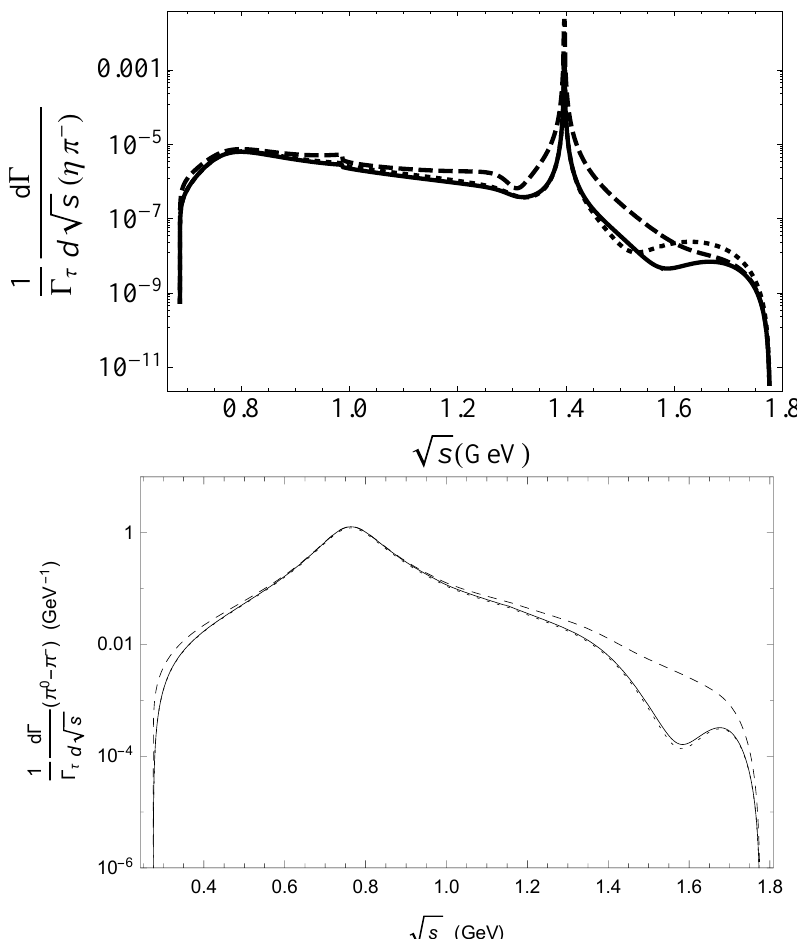
Figure 1: Normalized hadronic mass distributions (in GeV − 1 units; Γ τ is the tau decay width). The upper plot corresponds to τ − → π − ην τ : the solid line represents the SM contribution using [ 13 ] as the reference for form factors; the dotted (dashed) ε = 0 and ε = 0.6 (respectively, ε = 0.004 and ε = 0). The line corresponds to (cid:98) (cid:98) (cid:98) (cid:98) S T S T lower plot corresponds to τ − → π − π 0 ν τ using the form factor model of Ref. [ 21 ] : the solid line denotes the SM contribution; the dotted (dashed) line corresponds to ε = 0 and ε = − 0.014 (respectively, ε = 1.31 and ε = (cid:98) (cid:98) (cid:98) (cid:98) S T S T